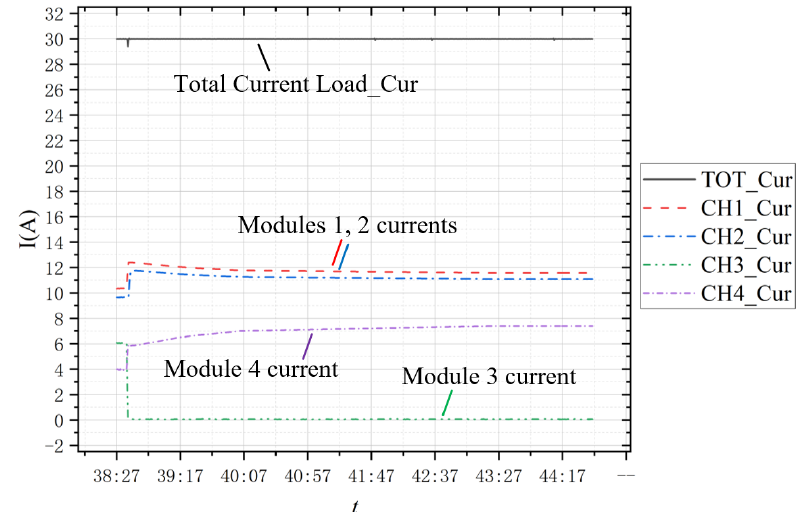
Figure 23. Current change after module 3 failure in thermal sharing